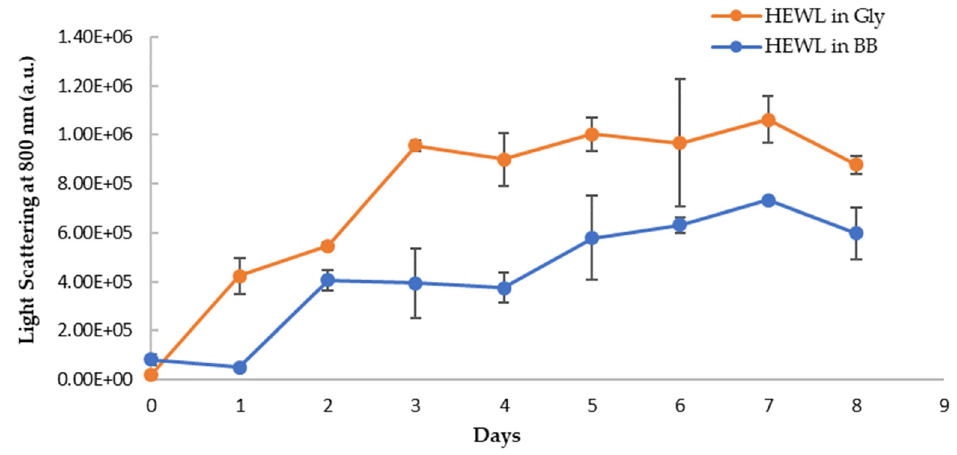
Figure 11. Turbidity (emission at 800 nm with excitation at 800 nm) of HEWL alone (orange) and blueberry-treated HEWL (blue) in glycine buffer. The error bars represent SD with three independent runs.